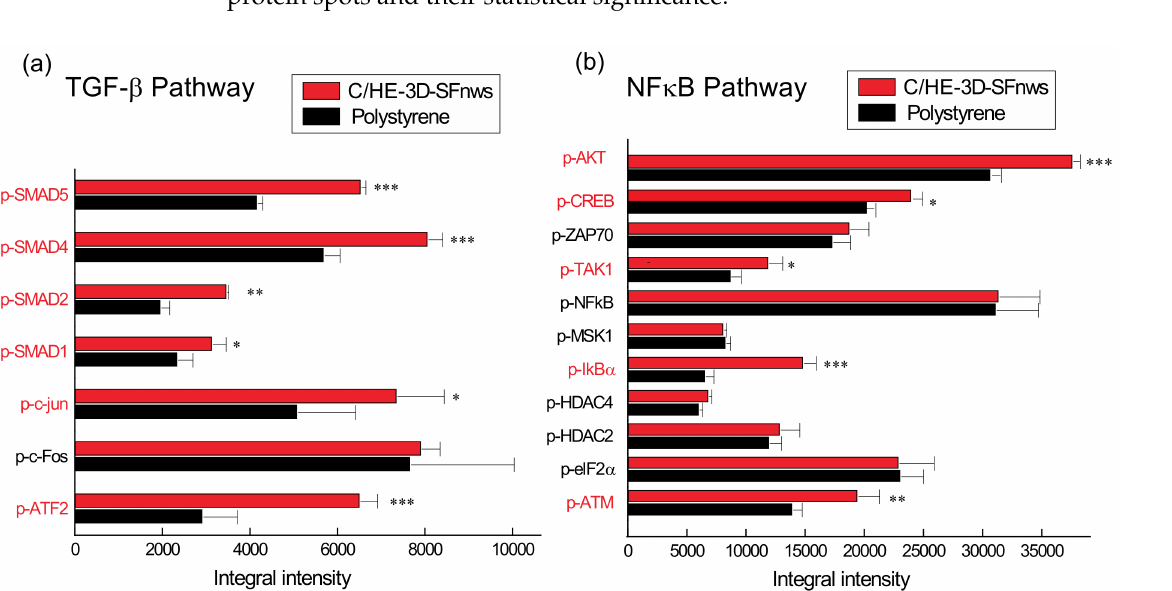
Figure 2. Signalling pathways activated in C/HE-3D-SFnws-attached vs. polystyrene-stuck AHSMCs. Equal amounts of total protein lysates from AHSMCs grown on either C/HE-3D-SFnws or polystyrene for 15 days in vitro were subjected to signalling pathway-specific membrane-based double-antibody arrays to assess any difference in specific sites phosphorylation of different pro- teins. The adhesion to C/HE-3D-SFnws significantly affects the activation of ( a ) TGF- β and ( b ) NF- κ B signalling pathways in AHSMCs. Abbreviations in red highlight the increased phospho- proteins. The integrated intensity values for each couple of specific protein spots and their levels of statistical significance are shown as the mean values ± standard deviations (SDs). *, p < 0.03; **, p < 0.002; and ***, p < 0.0005. For technical details, consult the Section 2.7.